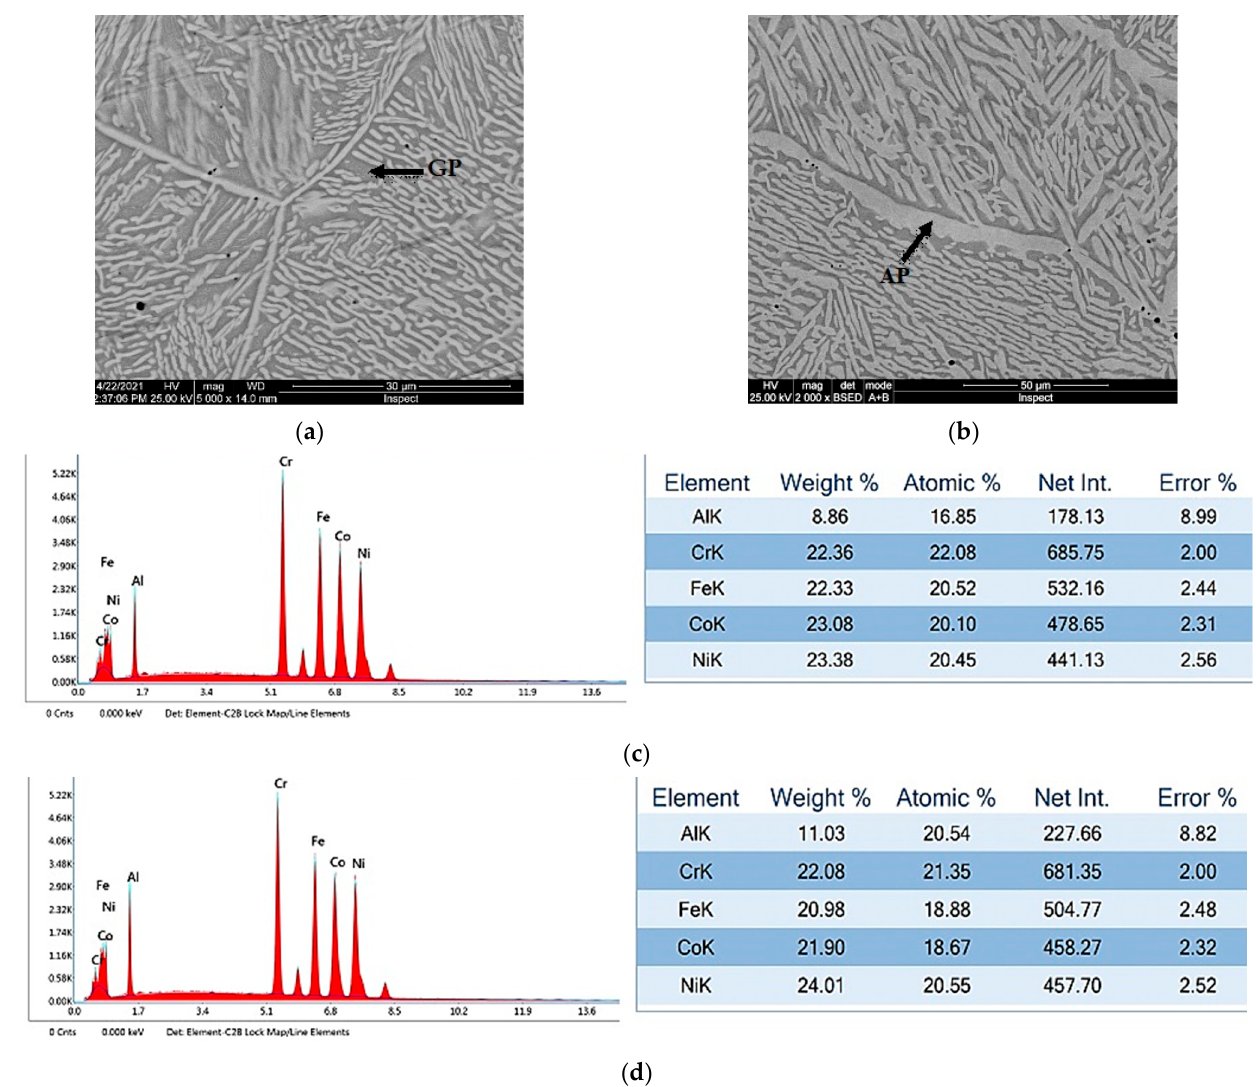
Figure 4. SEM microstructure of HEA sample: ( a ) longitudinal and ( b ) transversal cross-sections; ( c ) EDS analysis on gamma phase (GP) and ( d ) alpha phase (AP).